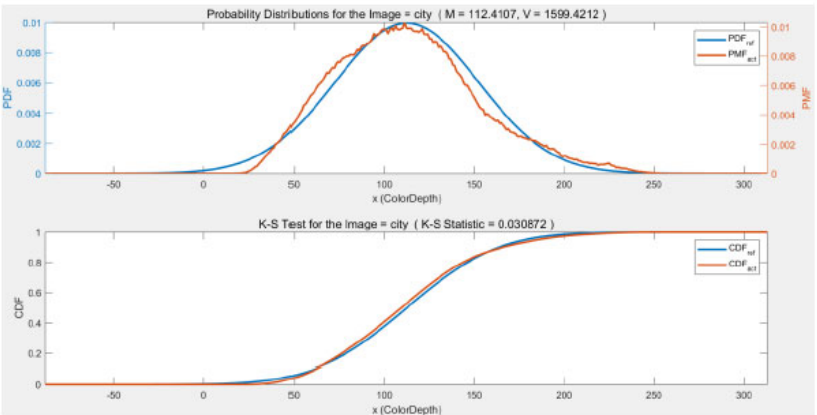
Figure 13. Histogram and Cumulative Distribution for